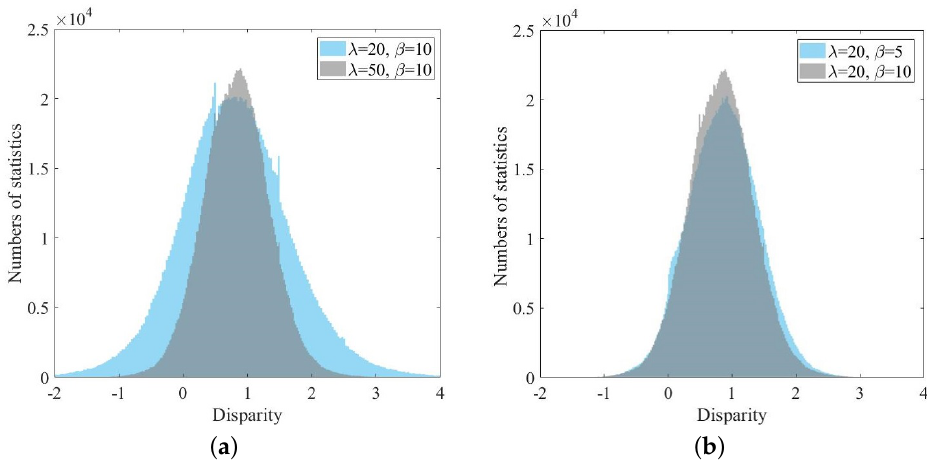
Figure 11. The histogram of the disparity map to explore the effect of the ( a ) smoothing parameter λ and ( b ) cross-correlation parameter β